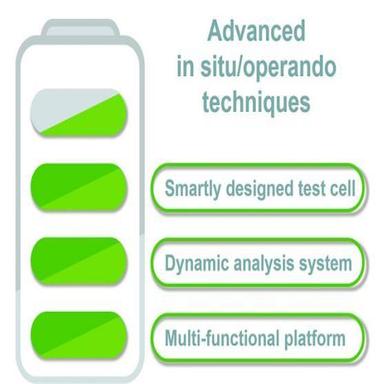
The illustration of in-situ/operando techniques for battery characterization in the future.